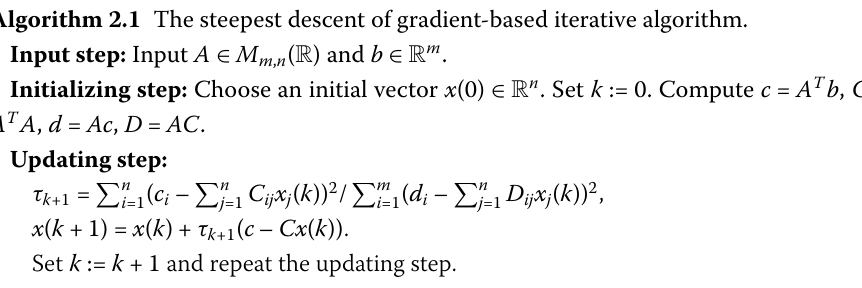
Algorithm 2.1 The steepest descent of gradient-based iterative